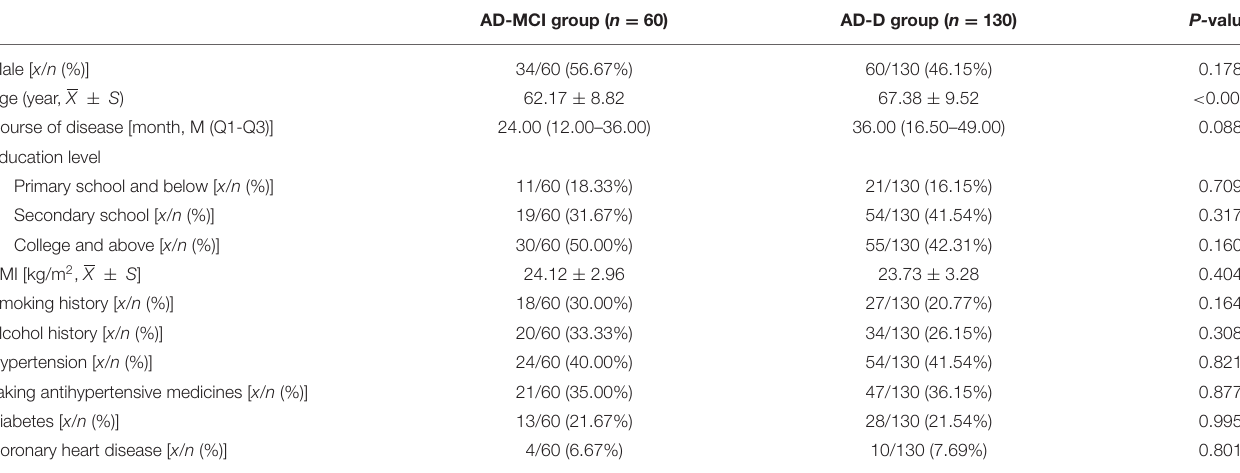
TABLE 1 | Comparisons of demographic variables between the AD-MCI and AD-D